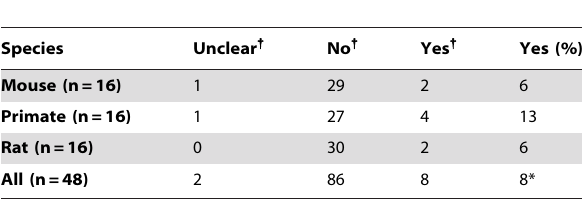
Table 21. Number of studies reporting raw data